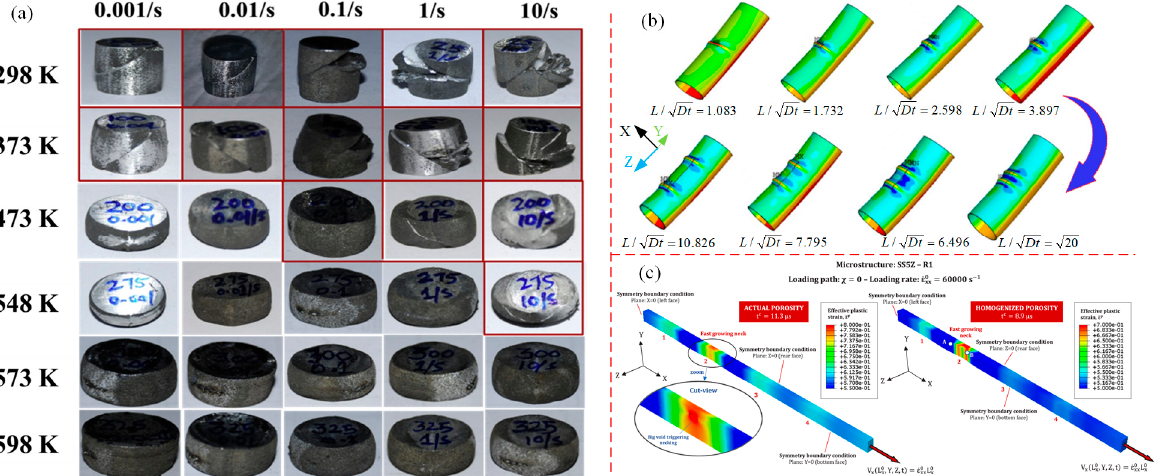
Figure 14. Only one research method using experiment or simulation: ( a ) hot compression experiment of magnesium alloy [176]; ( b ) wrinkling simulation of X80 steel tube [181]; ( c ) dynamic tensile simulation of porous microstructure [182].